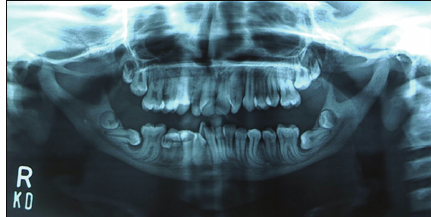
Figure 4: Panoramic radiographic findings.